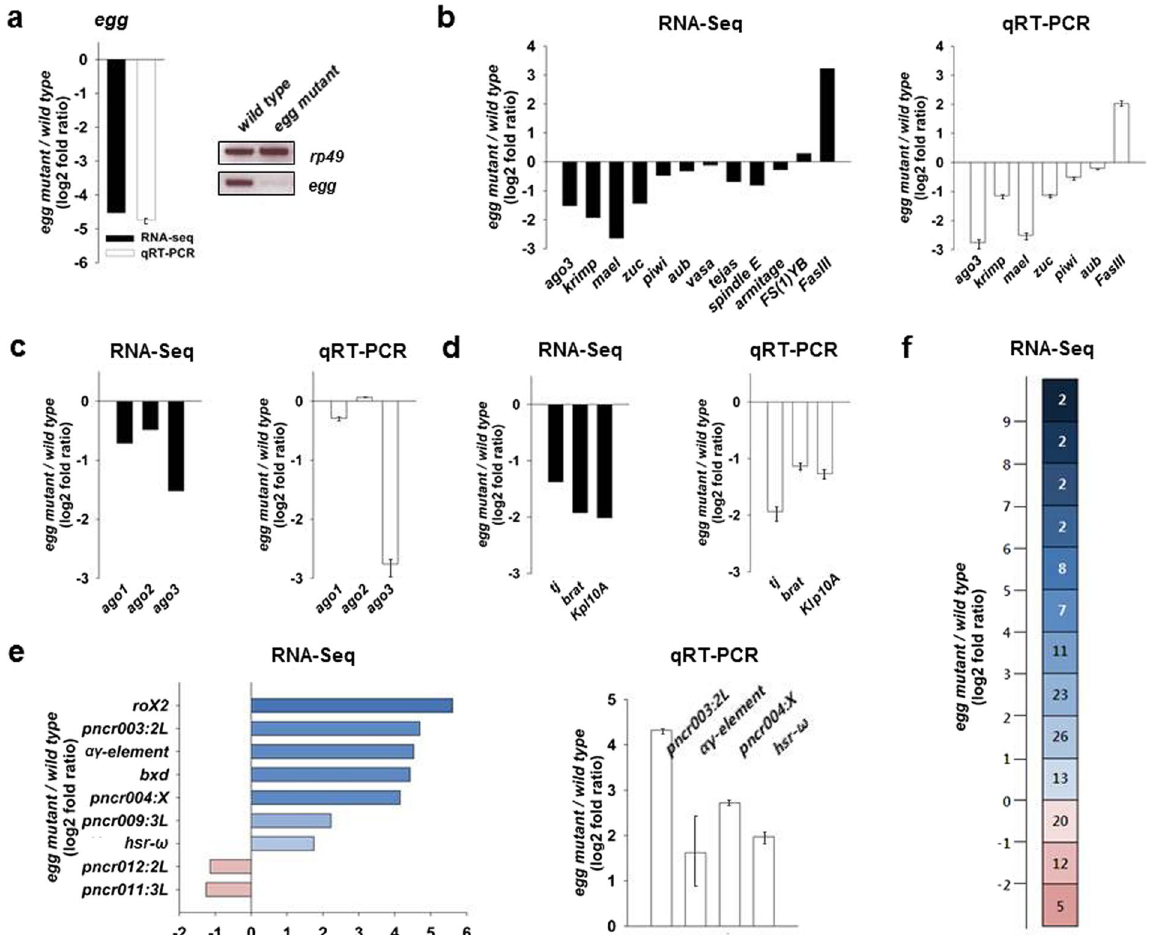
Figure 1. Egg regulates the expression of particular piRNA pathway genes and some lncRNAs. Differentially expressed genes by loss of Egg were identified from RNA-seq data (black bar) using the criteria of fold change ≥ 2. Fold changes are shown on the log 2 scale ( egg mutant/wild-type). qRT-PCR assays (white bar) were performed at least three times to confirm the RNA-seq data. Error bars represent standard deviation. ( a ) Expression level change of egg gene. egg expression was significantly reduced in egg mutant ( egg 2138 /Df(2R) Dll-Mp ) ovaries compared with wild-type ovaries. rp49 was used as a control. ( b ) Representative expression profiles of piRNA pathway genes. Expression levels of ago3 , krimp , mael , and zuc were downregulated in egg mutant ovaries. Consistent with zuc downregulation, FasIII expression was upregulated in egg mutant ovaries. ( c ) Expression level changes of Ago family members. Unlike ago3 , expression of ago1 and ago2 was not significantly changed in egg mutant ovaries. ( d ) Expression level changes of genes for genic piRNAs. Expression levels of tj , brat , and klp10A genes which contain 3 ′ -UTR piRNA clusters were downregulated in egg mutant ovaries. ( e ) Representative expression profiles of lncRNAs. Some well-known Drosophila lncRNAs, such as roX2 , αγ -element , bxd , and hsr- ω were upregulated whereas some putative lncRNA genes, such as pncr011:3L and pncr012:2L , were downregulated in egg mutant ovaries. ( f ) Summary of expression profiles of putative lncRNA genes. Differentially expressed putative lncRNA genes are shown with the number of genes. The fold change on the log 2 scale is placed on the vertical axis. Eighty-three genes were upregulated ( ≥ + 1) whereas 17 genes were downregulated ( − 1 ≥ ) in egg mutant ovaries. See also Supplementary Table